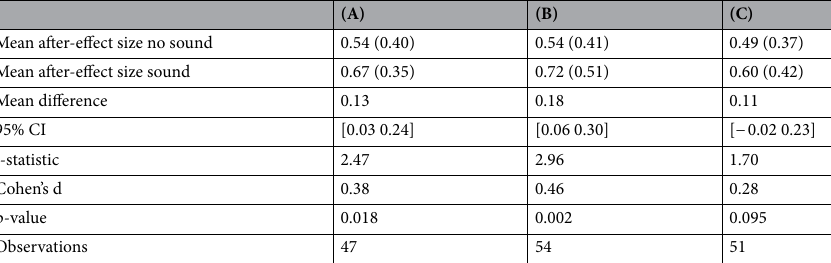
Table 1. Comparison of after-effect size in the experimental treatment with sound (“sound”) vs. the treatment without sound (“no sound”), for each experiment. (A) First experiment. (B) Matched white noise experiment. (C) Crossover test. The table reports the magnitude of the after-effect averaged across all trials and participants (standard deviations in parenthesis). The mean difference (sound–no sound), as well as t-statistics, Cohen’s d and p-values of a 2-sided Welch t-test of the null hypothesis that the difference is null, are also